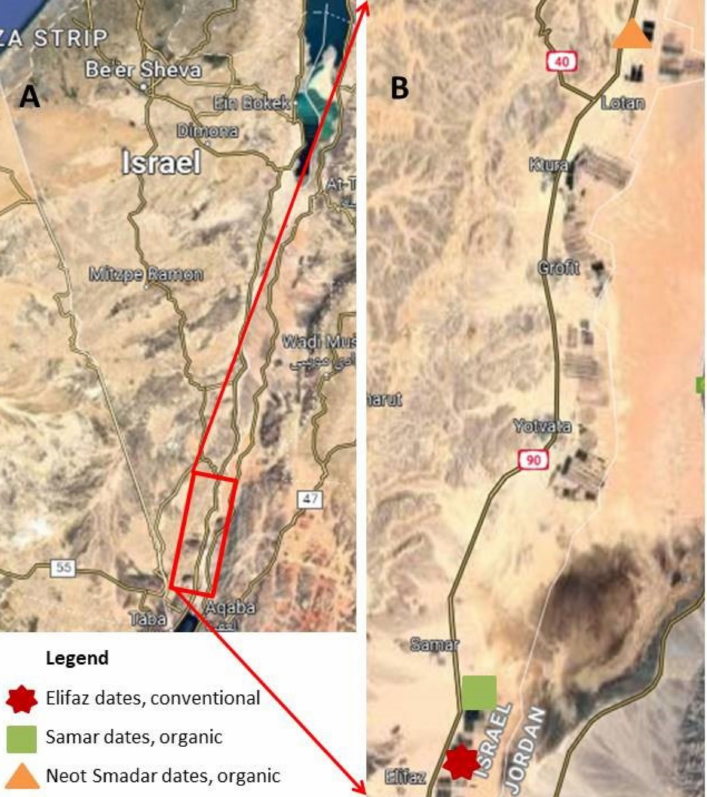
Figure 1. ( A ) Overview map of the South of Israel indicating the location of the research area displayed with a red rectangle. ( B ) Location of the three date plantations in the Southern Arava marked with different colorful